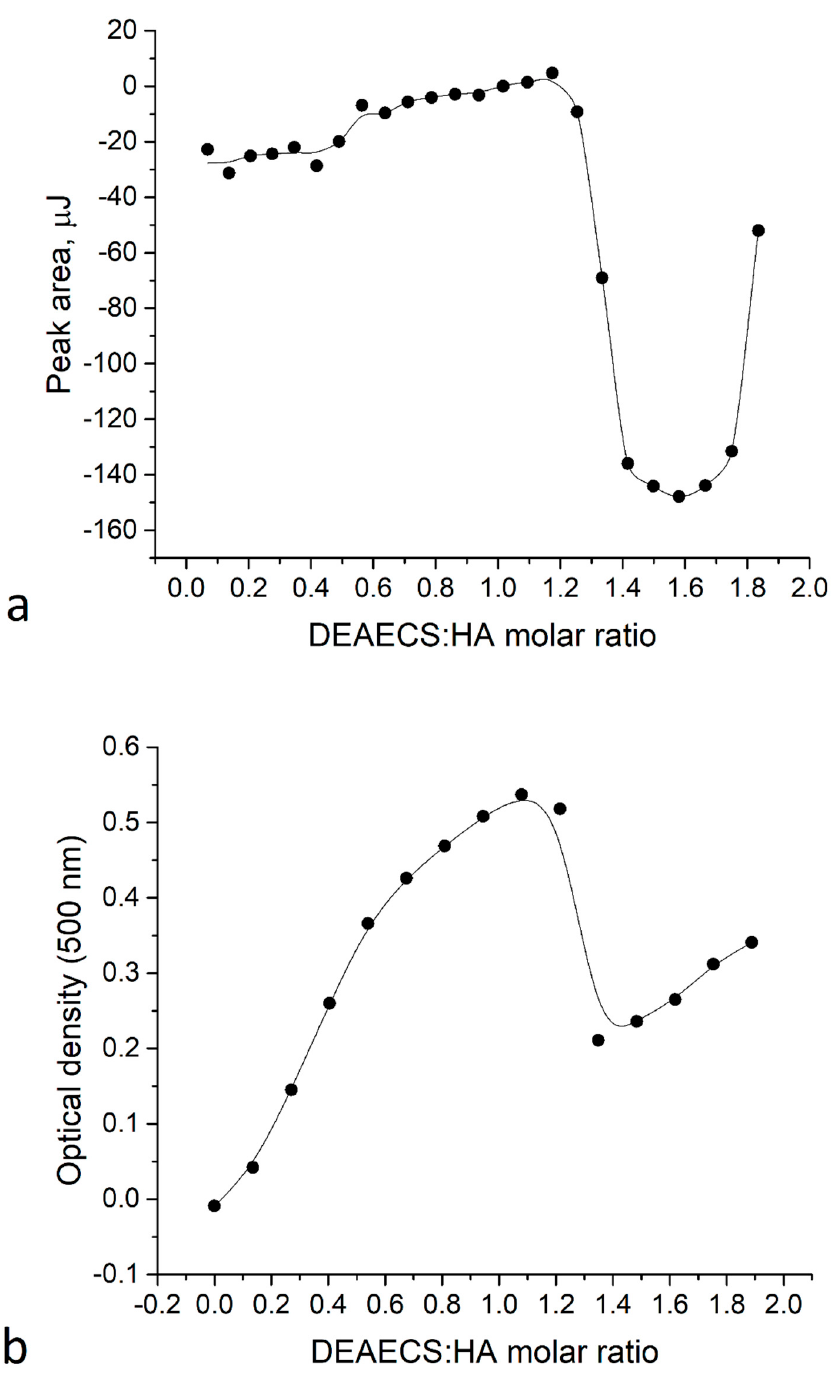
Figure 1. ( a ) Isothermal titration calorimetry (ITC) titration curve; ( b ) Turbidimetry data for HA 54 titration by DEAECS 84 .